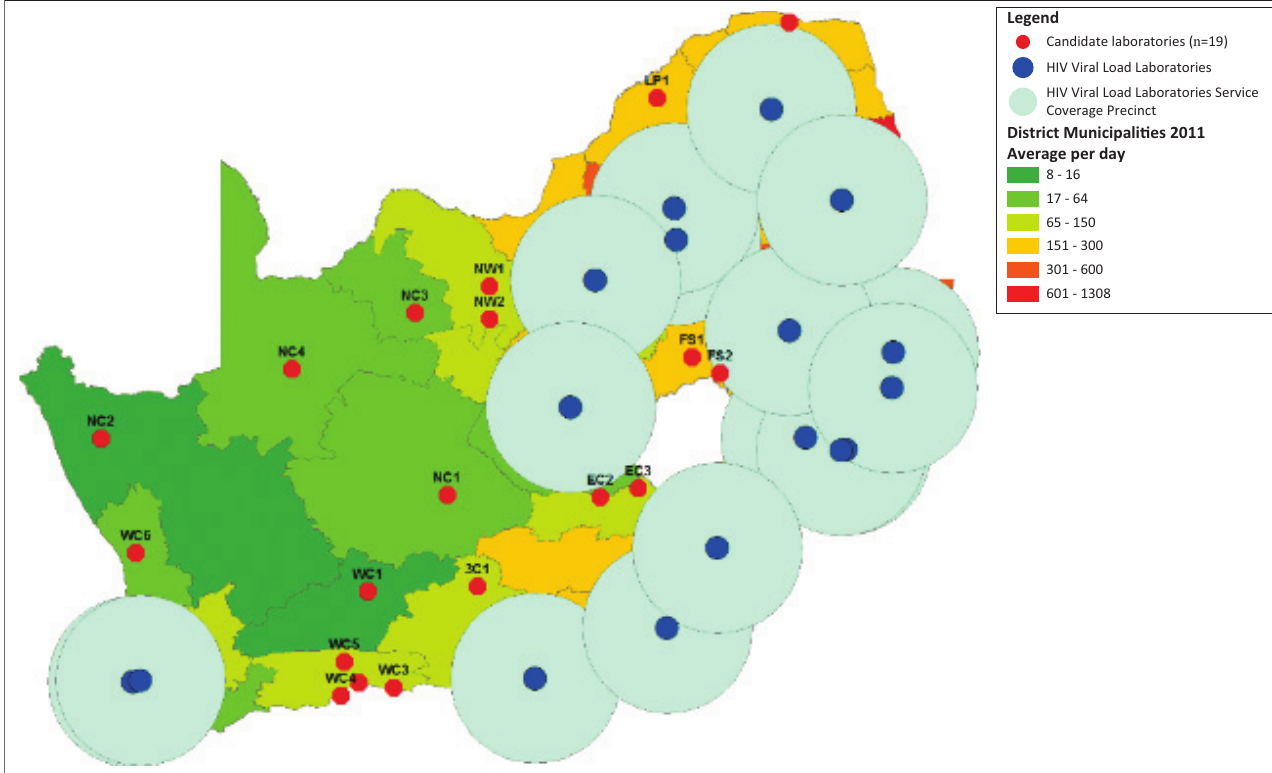
District Municipali(cid:18)es 2011 Average per